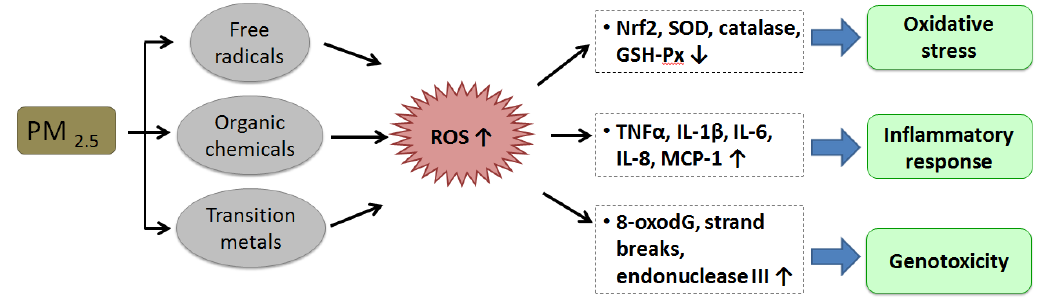
Figure 1. The potential mechanisms of PM 2.5 on disease progression. The cellular toxicity components, mainly including free radicals, organic chemicals, and transition metals, of PM 2.5 may induce or produce reactive oxygen species (ROS) that impair the cellular physiological/biochemical processes by the mechanisms of inducing oxidative stress, inflammation, genotoxicity, and others, altering the normal physiological functions and/or fates of target cells, resulting in damage of the tissues and organs.